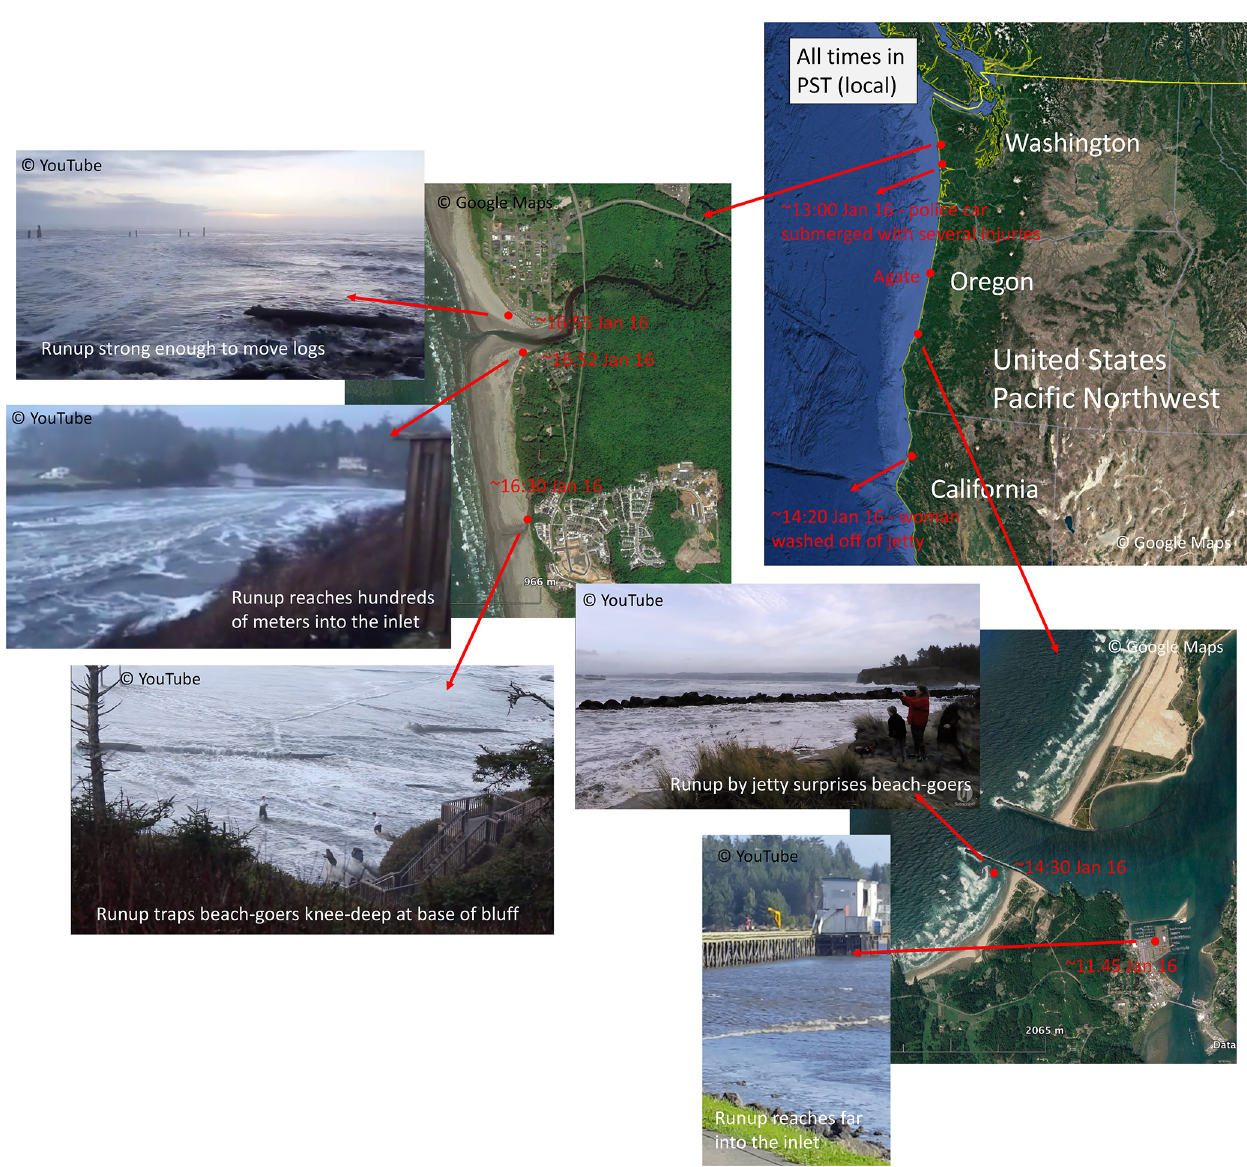
Figure 2. Location and approximate occurrence time of 16 January 2016 large wave runup events and stills from videos taken by bystanders. Photos are from https://youtu.be/JMYLvSsWR_g (last access: 5 October 2020), The Oregonian (2020), ehings12 (2020), Information planet Z (2020), and Leaming (2020); maps are from © Google